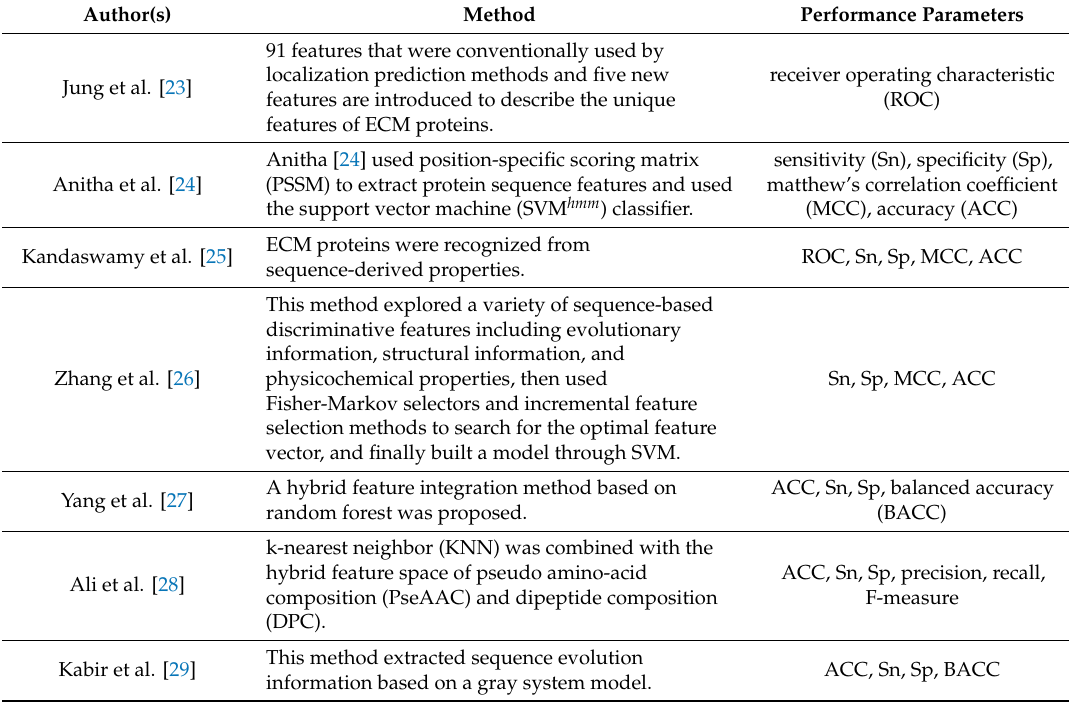
Table 1. The existing extracellular matrix (ECM) proteins prediction